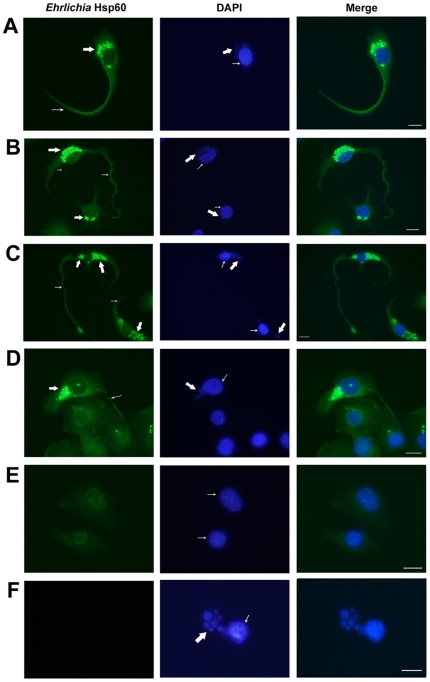

E. muris is associated with the filopodia of DH82 cells.(A–C) Filopodium extending from the cell body of an E. muris- infected DH82 cell. Left: E. muris-infected DH82 cell probed with anti-Ehrlichia Hsp60 antibody. Thick arrow indicates E. muris, and thin arrow indicates filopodium. Middle: E. muris-infected cell stained with DAPI. Thick arrow indicates DNA of E. muris stained with DAPI, and thin arrow indicates host nucleus. Right: Merged figure. Scale bar, 25 micrometers. (D) Filopodium of an E. muris- infected DH82 cell extended to a neighboring cell. (E) Uninfected DH82 cells. (F) Absence of Ehrlichia Hsp60 primary antibody resulted in absence of staining E. muris in infected DH82 cells, but DAPI stained the E. muris DNA and DH82 nucleus.